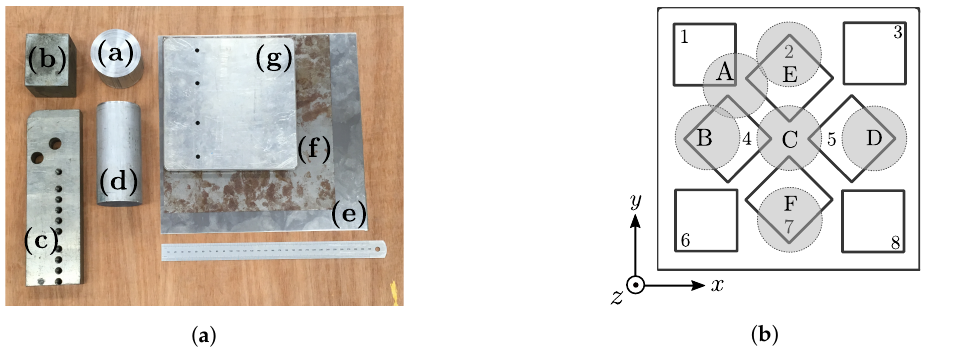
Figure 8. ( a ) Photograph of the metallic distorters used in the experiment. The properties of each distorter are shown in Table 2. ( b ) Illustrated top-down view of the transmitter board showing the locations of the distorters used in experiments. Table 2. List of distorters used in the experiment.